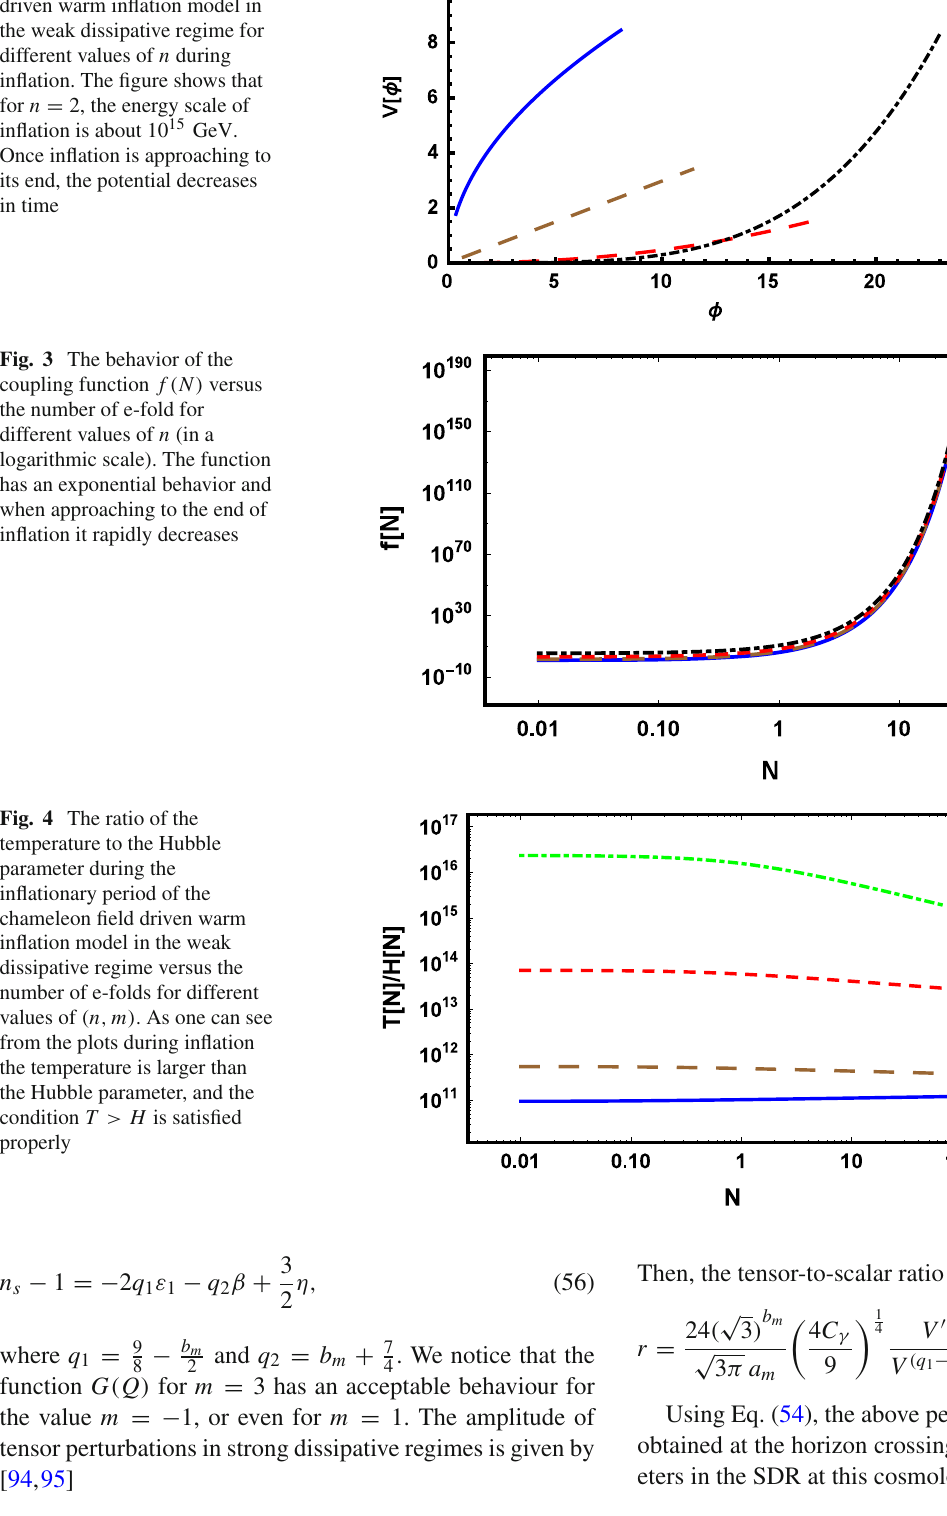
Fig. 2 The behavior of the scalar field potential V (φ) versus φ of the chameleon field driven warm inflation model in the weak dissipative regime for different values of n during inflation. The figure shows that for n = 2, the energy scale of inflation is about 10 15 GeV.